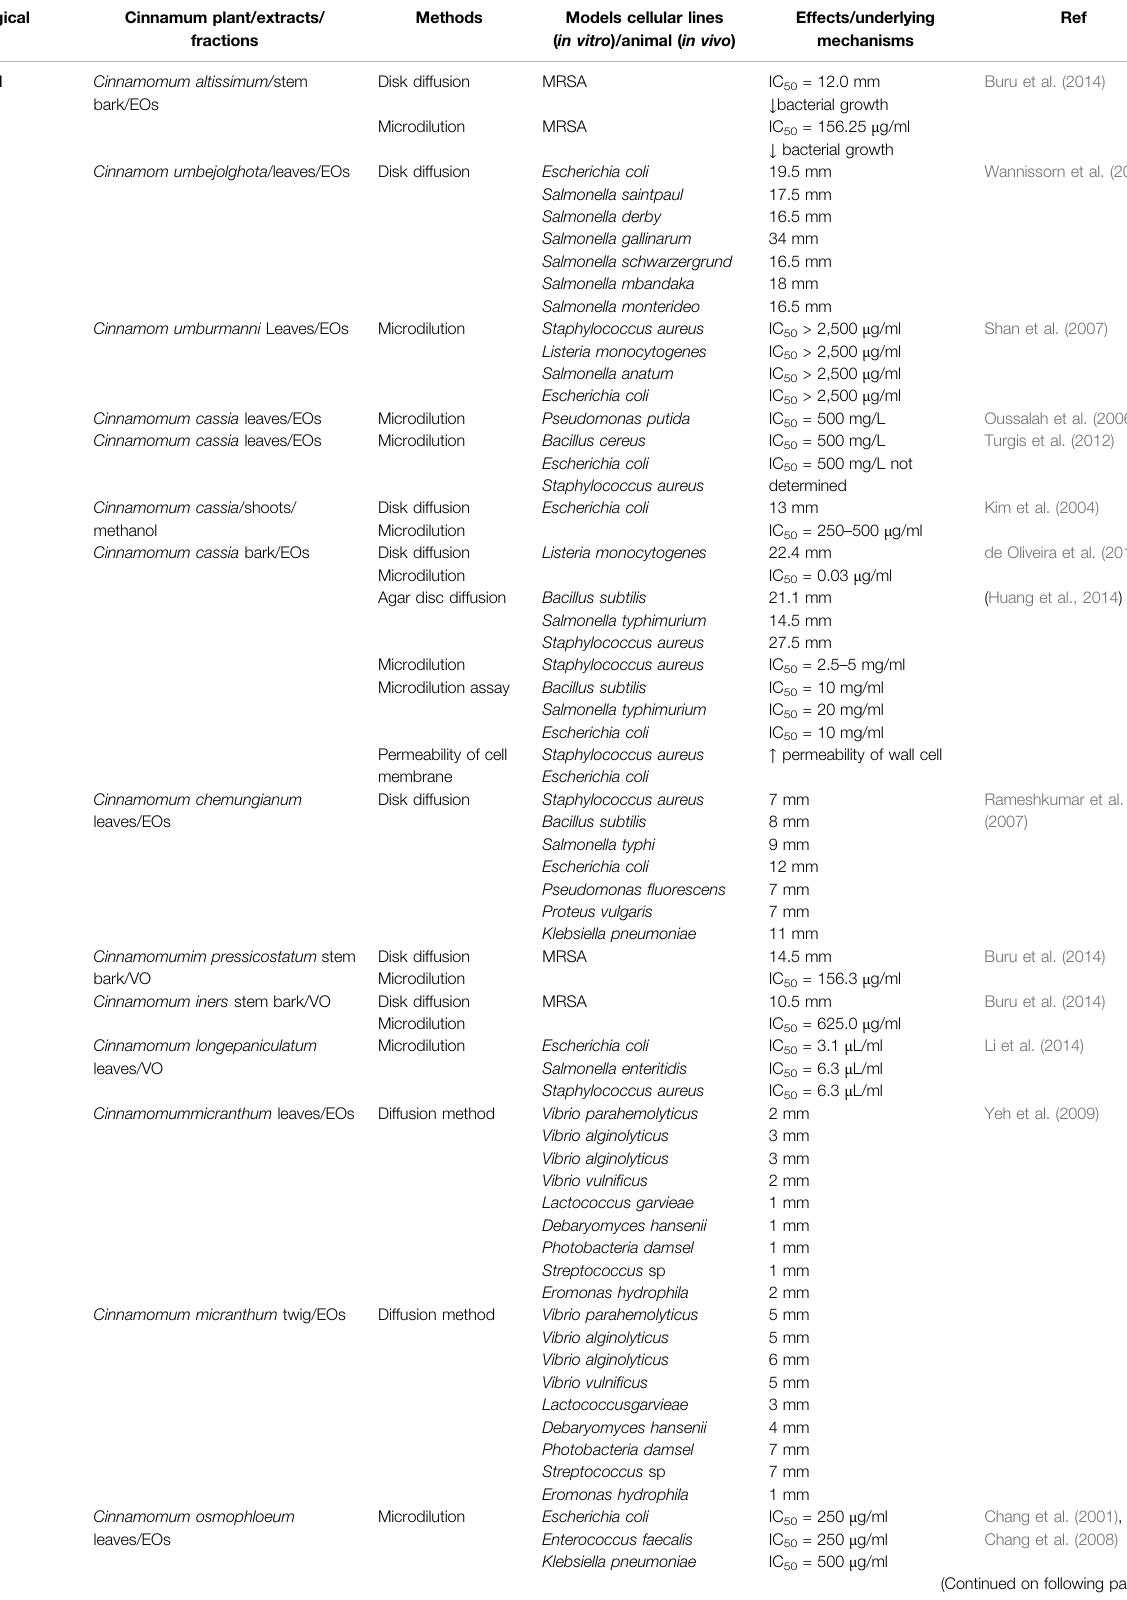
TABLE 2 | Preclinical pharmacological activities of Cinnamomum